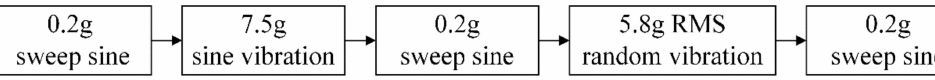
Figure 14. Flowchart of the mechanical vibration